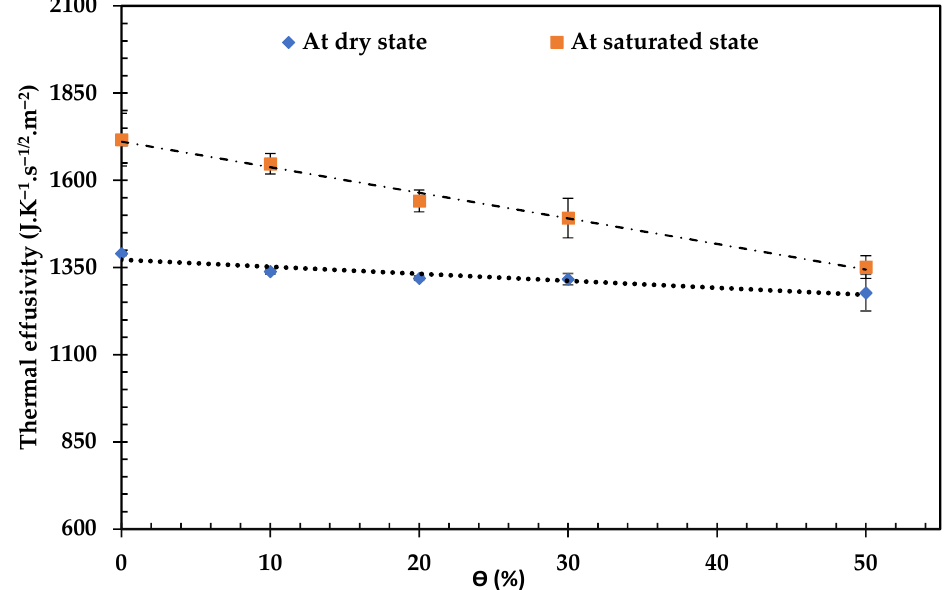
Figure 16. Thermal effusivity variation of modified concrete as function of RWG volume rate at dry and saturated states.